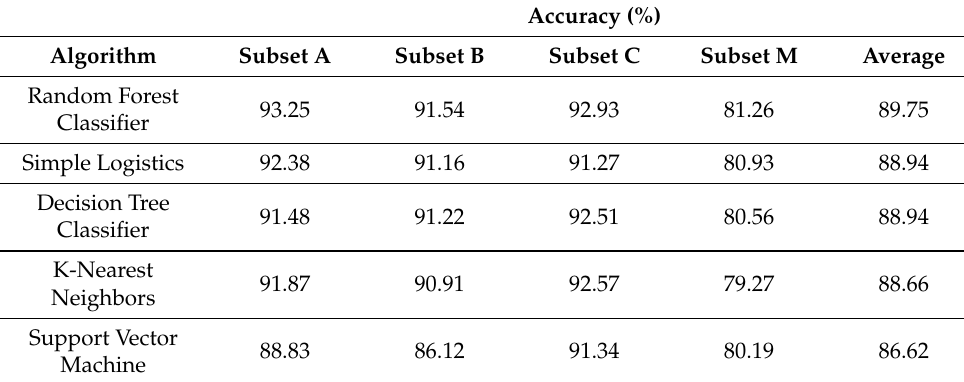
Table 2. Results of the accuracy of each algorithm for each